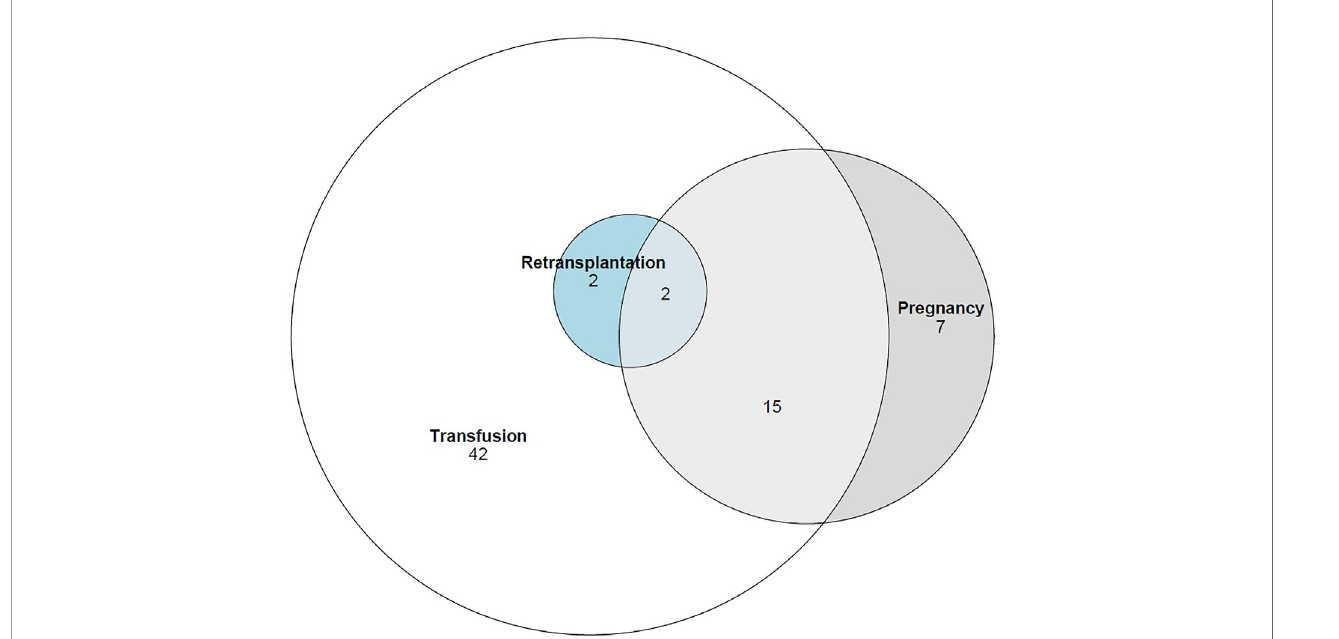
FIGURE 1 | Causes of sensitization in the overall cohort.